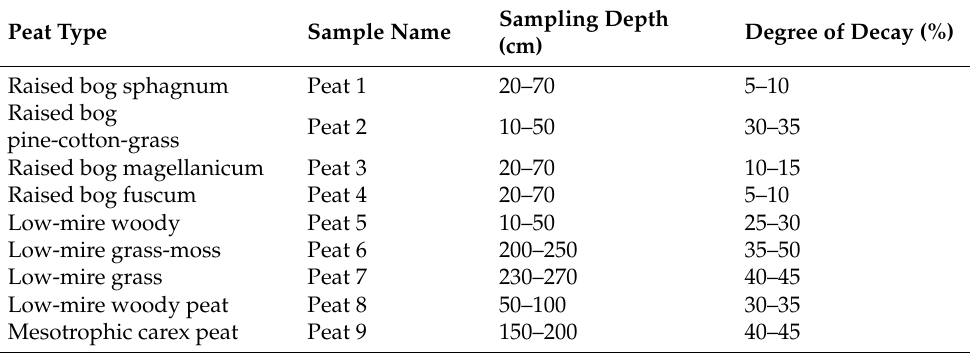
Table 1. Short description of the peat